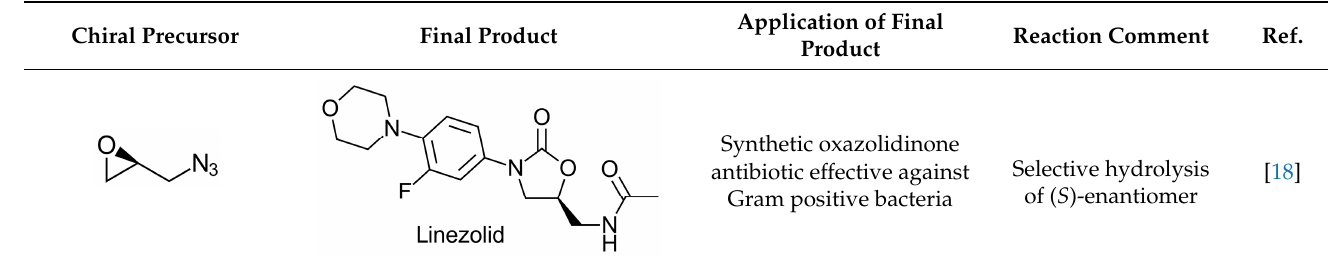
Table 1. Chiral precursors that can be prepared by EHs and the products that can be synthesized from from them.